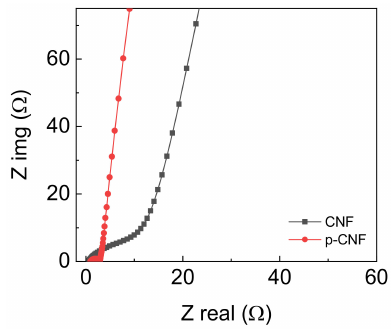
Figure 5. Nyquist plots of CNF and p-CNF electrodes.